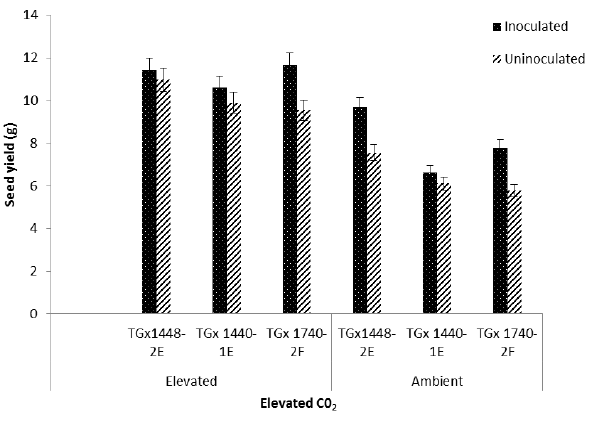
Fig. 1. Rainfall pattern of the experimental location during 2015 cropping season